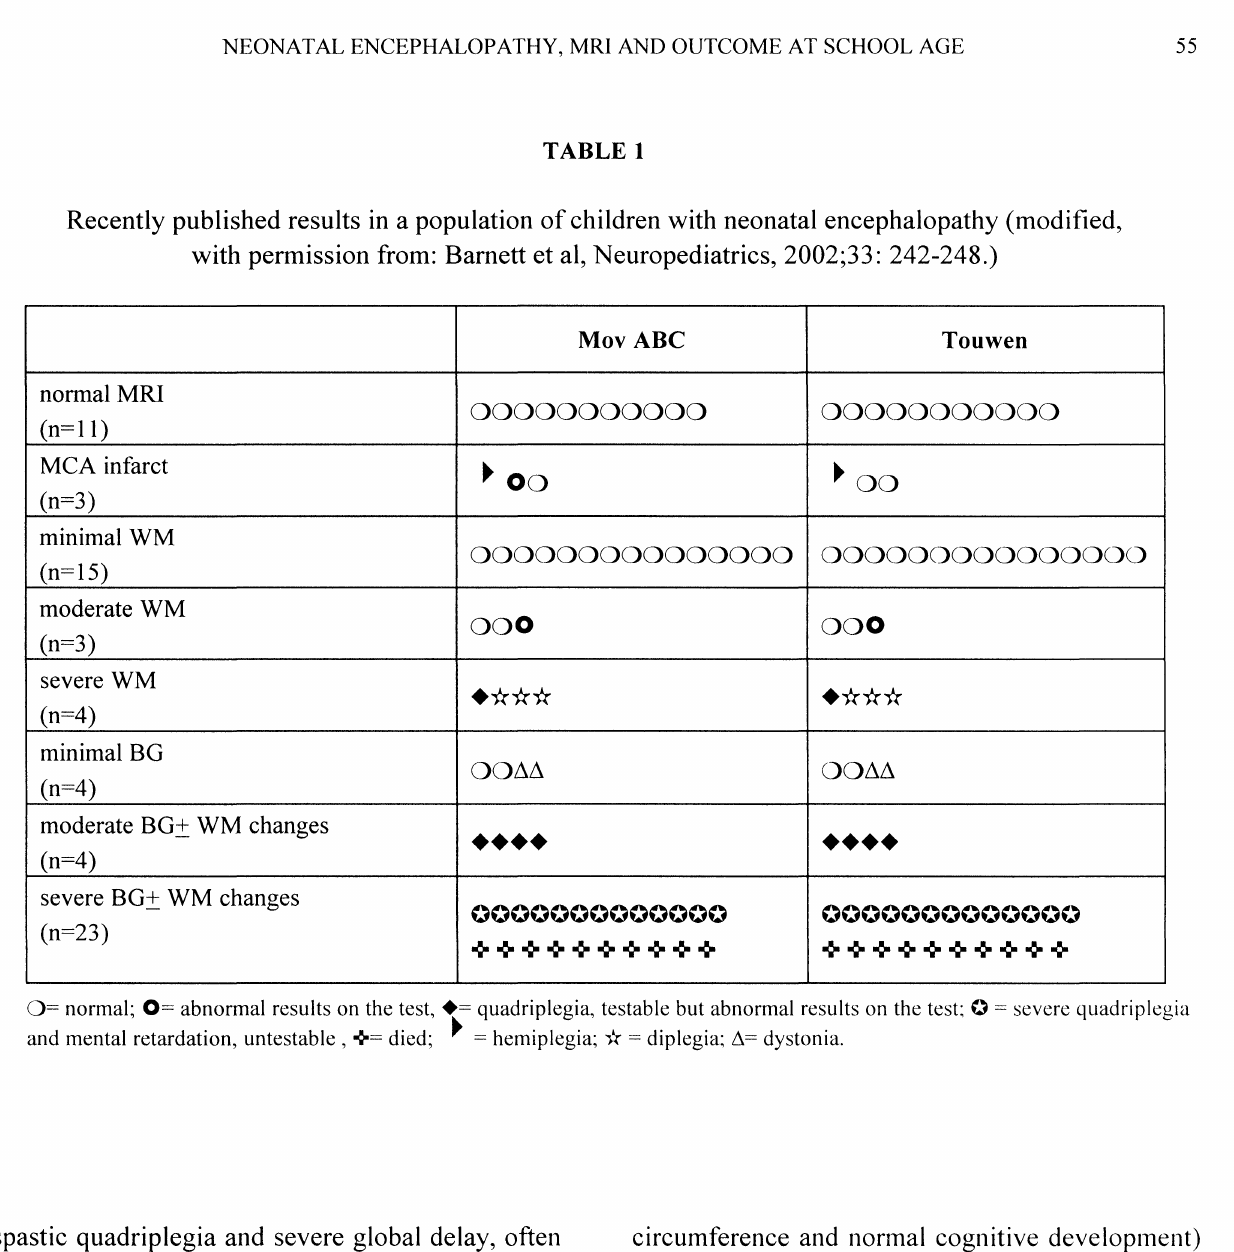
Recently published results in a population of children with neonatal encephalopathy (modified, with permission from: Barnett et al, Neuropediatrics, 2002;33"